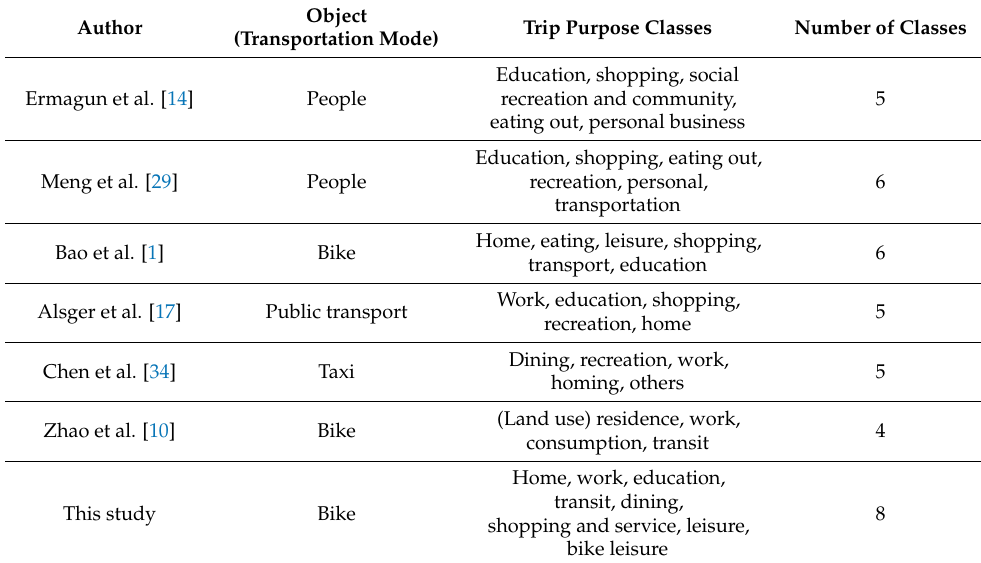
Table 3. Trip purpose classifications in previous studies and the present